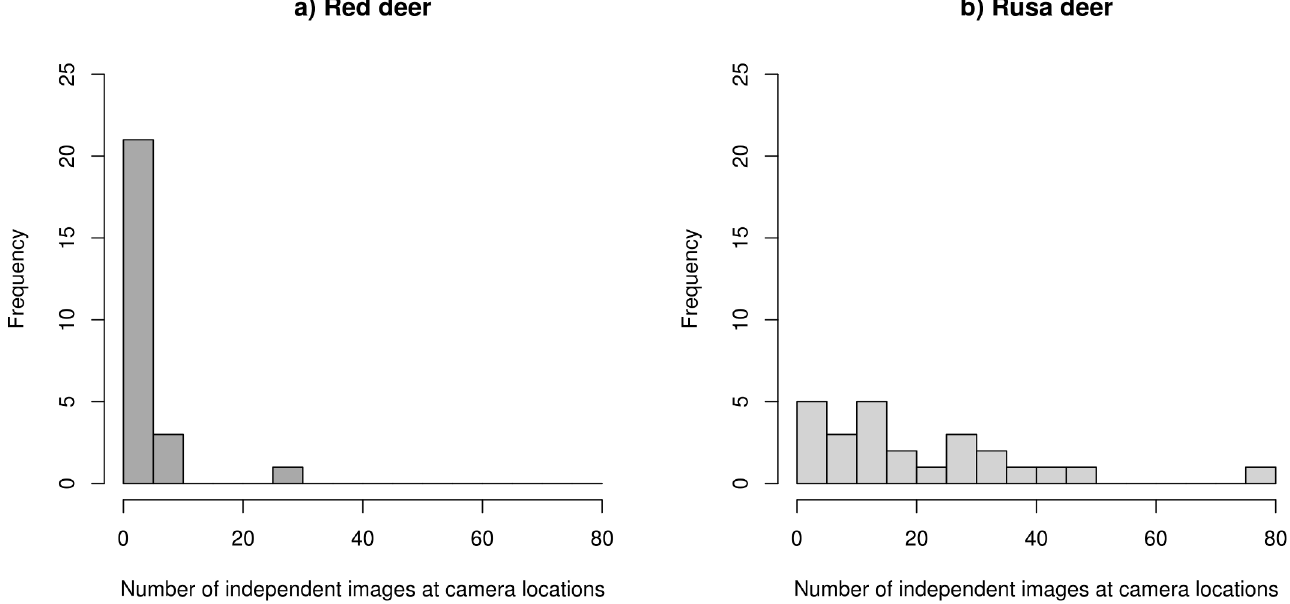
Fig 3. Frequency distributions of independent images of red deer (a) and rusa deer (b). Histograms are given for each deer species, with data from camera locations pooled across seasons and years (with bins 0 – 4, 5 – 9,